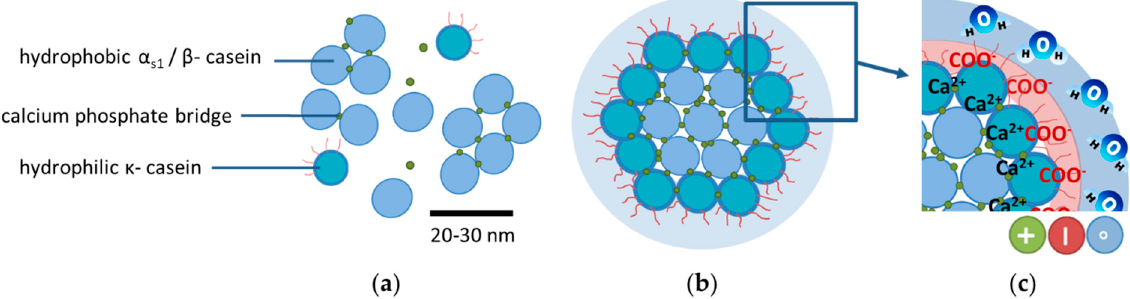
Figure 1. Schematic diagram of casein submicelles ( a ) forming a whole casein micelle ( b ). When suspended in water, an electric bilayer is formed at the CM surface ( c ) (for detailed description see text).